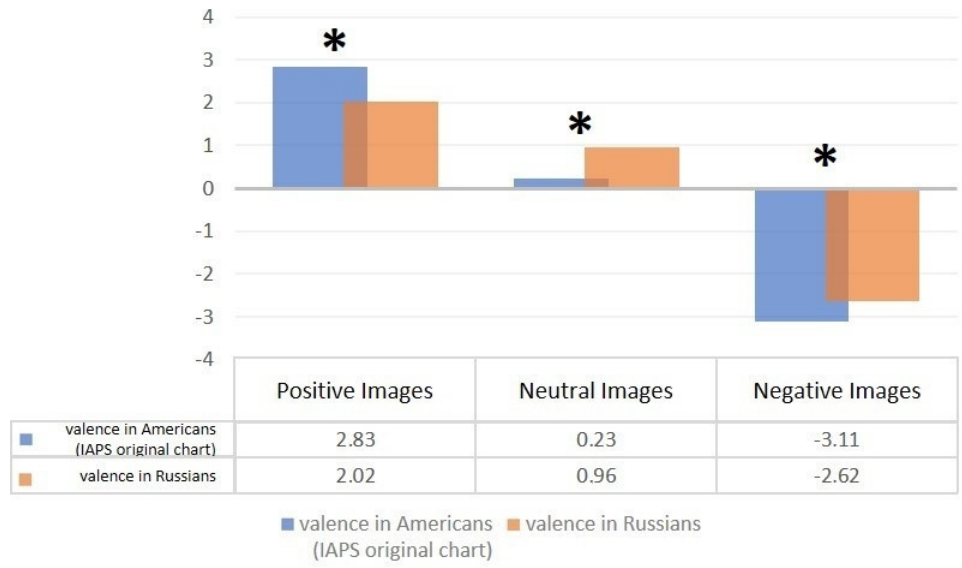
Figure 7. Comparison of mean values of IAPS stimulus valence between the American and Russian samples using the Wilcoxon signed–rank test.